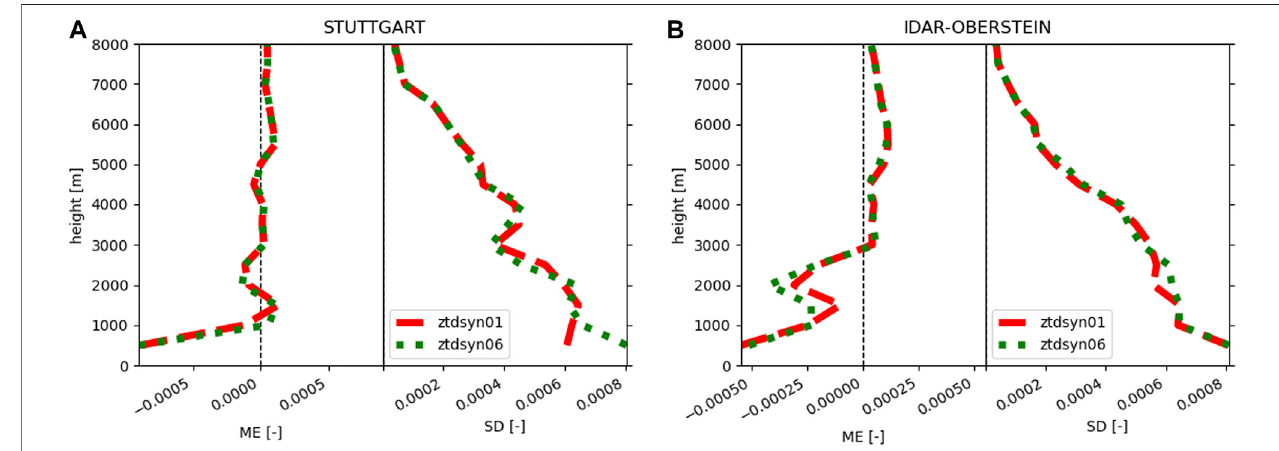
FIGURE 6 | As in Figure 4 , but for the comparison of the assimilation of ZTD and synoptic data with 1 h (red) and 6 h (green) cycling rate at the Stuttgart (A) and Idar-Oberstein (B) location.